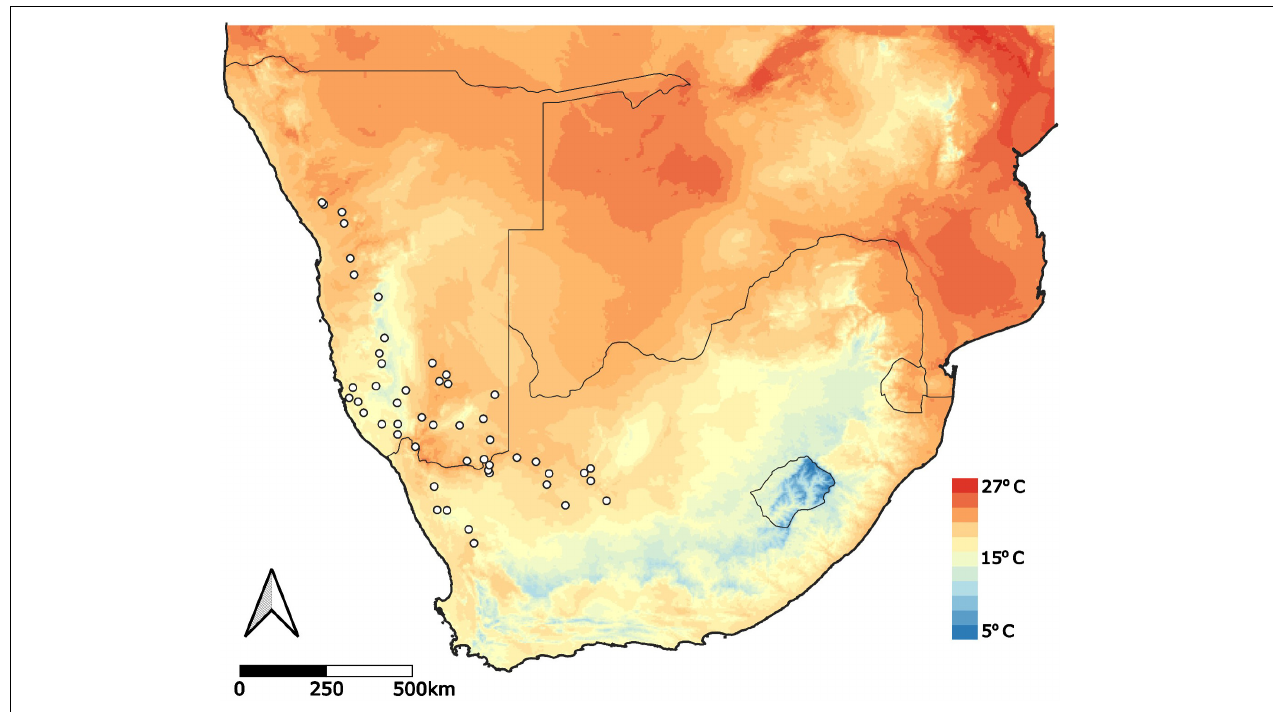
FIGURE 1 | Geographic range of Aloidendron dichotomum . Presence localities obtained from Foden et al. (2007) Diversity and Distributions, Foden (pers. obs.) and the Global Biodiversity and Information Facility (GBIF). Mean annual temperature (mean of all monthly temperatures) was obtained from WorldClim (Hijmans et al., 2005) at 2.5-min